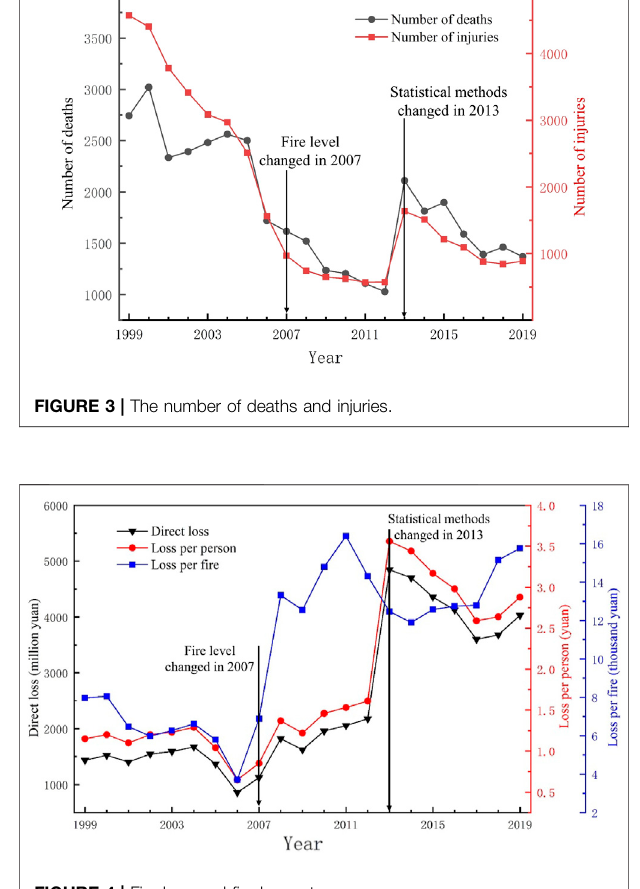
FIGURE 4 | Fire loss and fi re loss